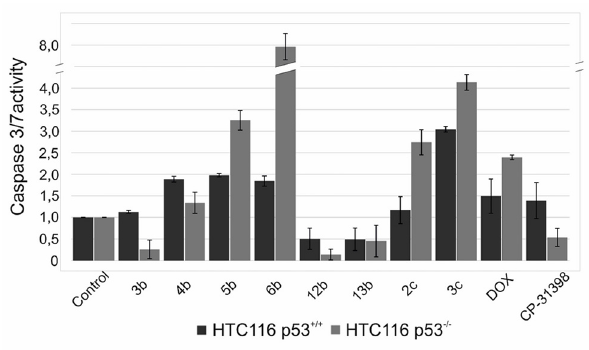
Fig 6. Caspase-3/7 activities on the HCT116 cell lines.